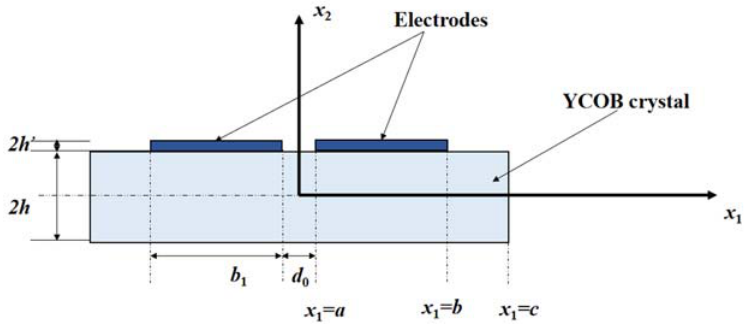
Figure 1. A monoclinic YCOB crystal plate with a lateral-field-excitation. The distributions of dielectric ( ε ) , piezoelectric ( e ) , and elastic ( c ) constants of z -cut monoclinic crystals with C m space group are as below,